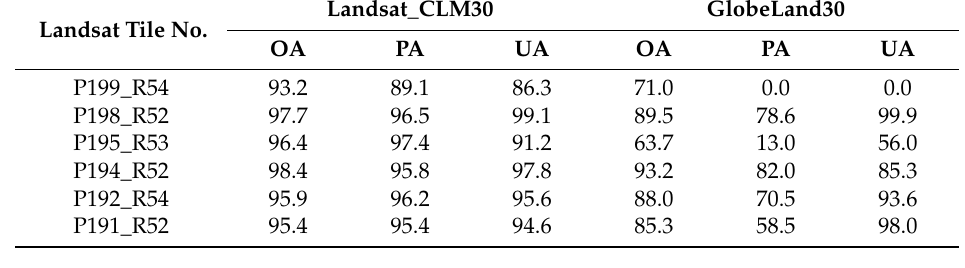
Table 2. Comparison of Landsat Classification results (Landsat_CLM30) with GlobeLand30. Overall accuracy, as well as the producer’s accuracy and user’s accuracy of the cropland class are reported.